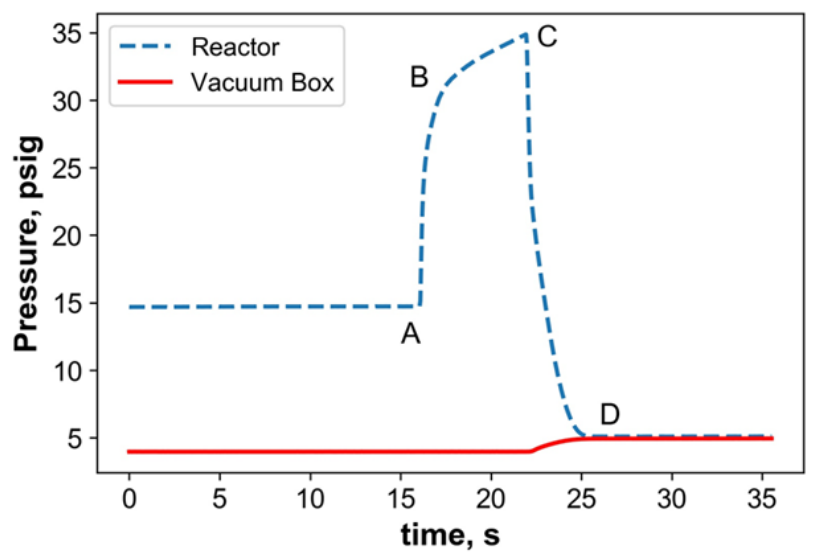
Figure 4. Pressure Changes in a 1992-CREC Riser Simulator Run for TIPB Cracking at the Following Conditions: C/O = 2.5, 530 °C, 5 s reaction time. Note: Blue broken line represents reactor pressure, red continuous line describes vacuum box pressure. Codes: A to B: vaporization, B to C: reaction, C to D: evacuation.